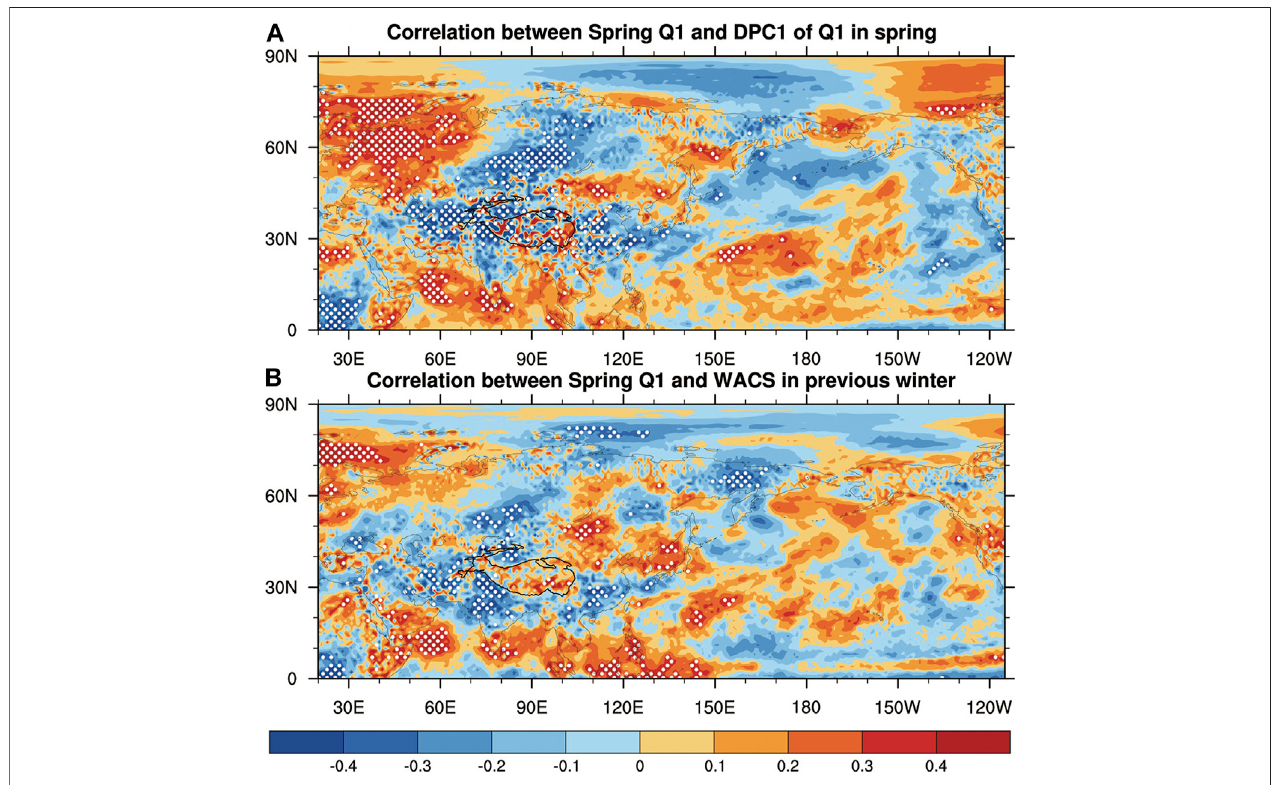
FIGURE8|(A) Spatialdistribution ofcorrelation coef fi cientsbetweenDPC1and 〈 Q 1 〉 . (B) Spatial distribution ofcorrelation coef fi cients betweenthewinterWACS index and 〈 Q 1 〉 . White dots indicate statistical signi fi cance at the 95% con fi dence level.